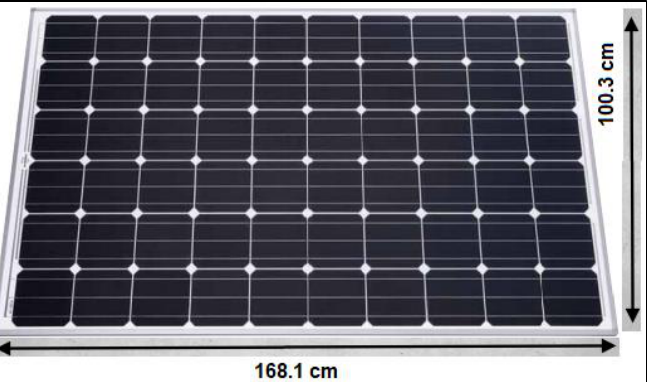
Figure 6: Used solar panel (Produced in Germany). Source: Authors, (2022).